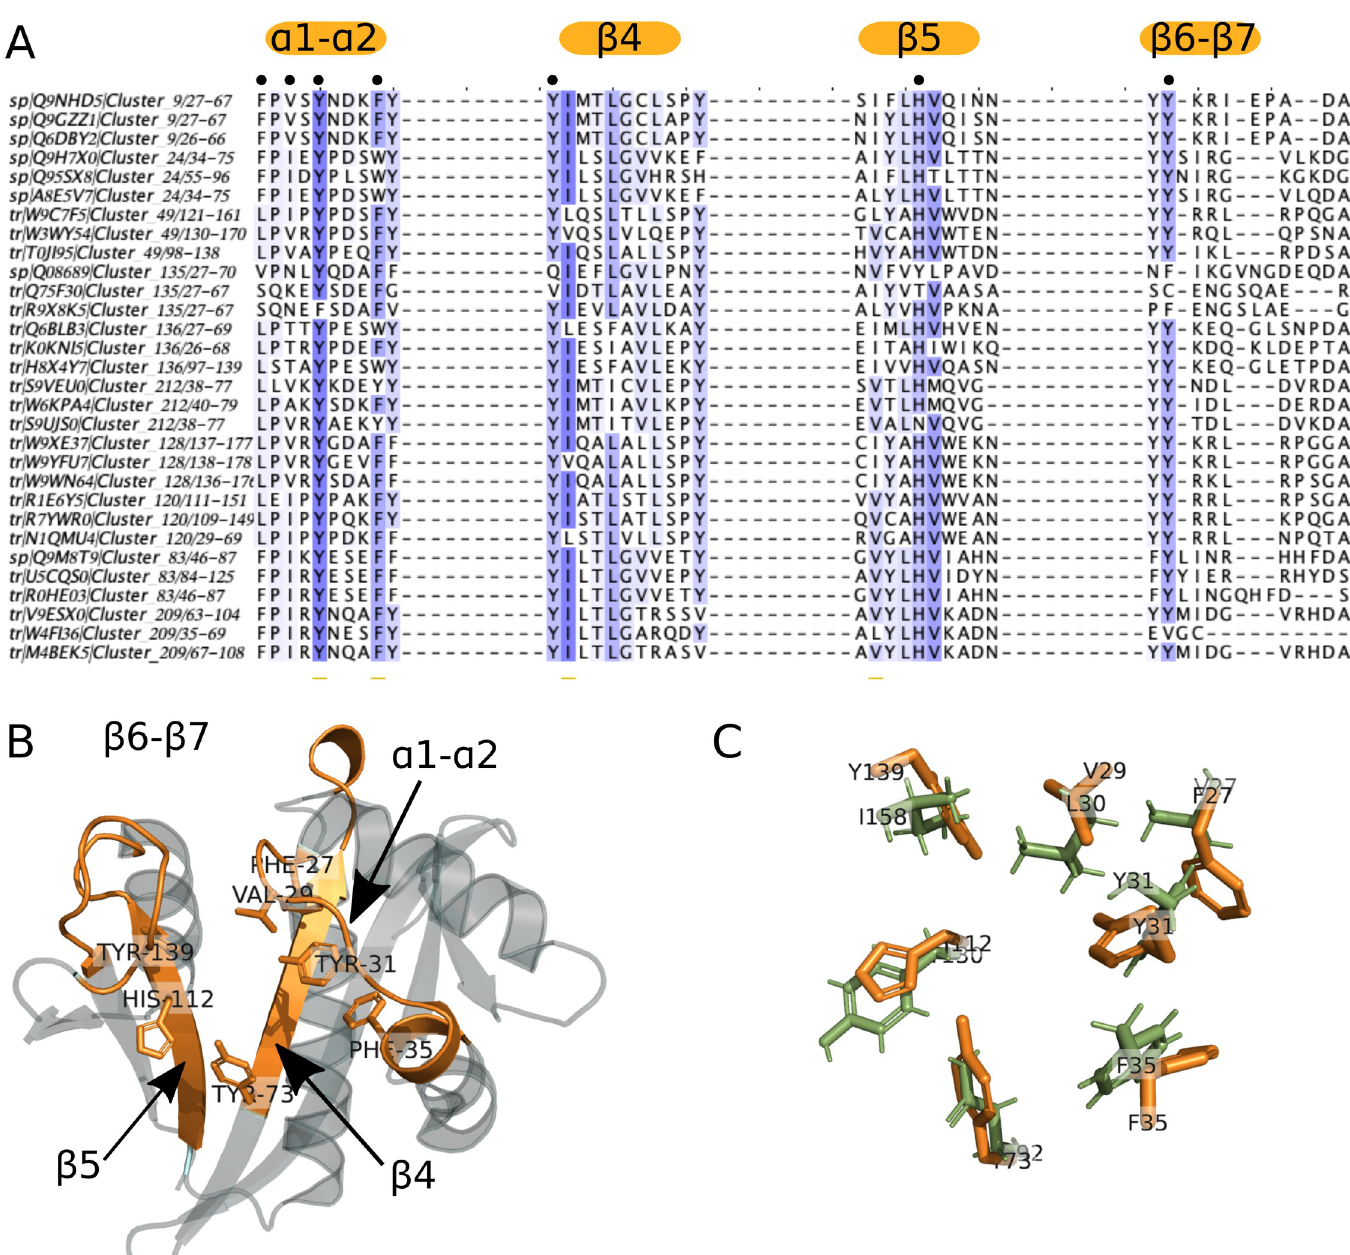
Fig 6. Variations of sequence motifs in key positions on the GNAT fold suggest novel NATs with different ligand specificities. When we compare the sequence motifs of NAA50 (cluster 9) and NAA60 (cluster 24) to the corresponding motifs of their surrounding clusters, we notice a number of small but meaningful differences ( A ). These differences occur on key positions of the GNAT fold and are illustrated here on the X-ray structure of NAA50 (PDB 3TFY) ( B ) The sequence differences located on the α 1- α 2 loop, β 4 and β 5 strands and β 6- β 7 loop residues are likely to result in altered specificity. The structure superimposition between human NAA50 from cluster 9 (orange, PDB 3TFY) and yeast NAA50 from cluster 135 (green, PDB 4XNH) highlights the small differences between residues involved in substrate binding in these two proteins with reportedly different specificities [88] ( C